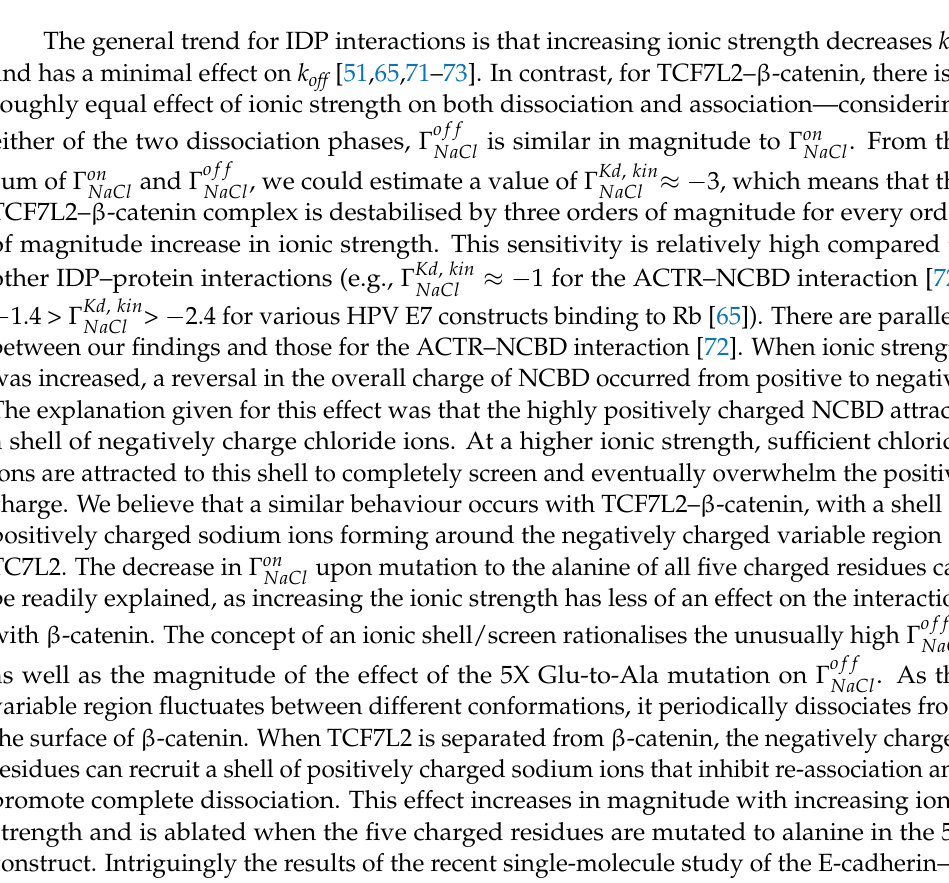
Figure 8. Schematic showing the proposed mechanism of dissociation of TCF7L2– β -catenin complex. TCF7L2 is in red, and β -catenin in cyan. ( A ) shows the sequential dissociation pathway in which the C-terminal region of TCF7L2 always dissociates before the N-terminal region. ( B ) For destabilising N-terminal mutants, there are two parallel dissociation pathways in which either the N-terminal region or the C-terminal region dissociates